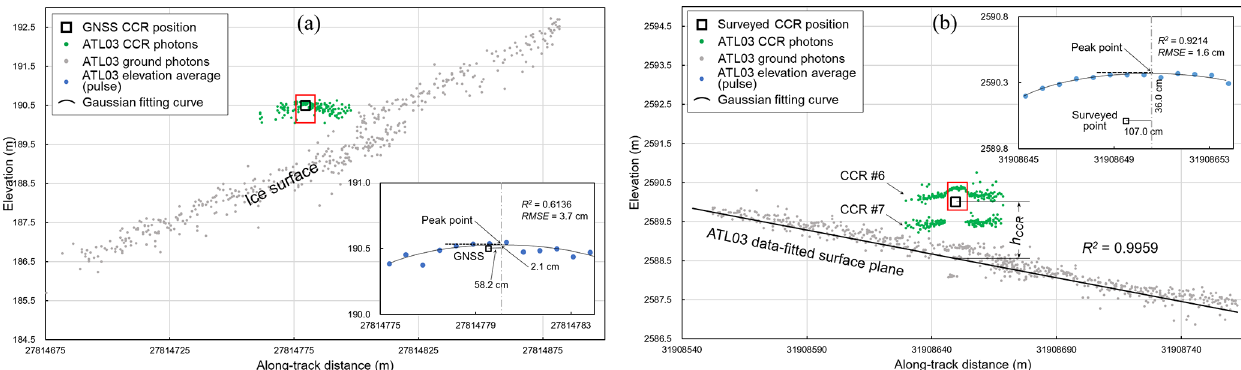
Figure 6. (a) CCR experiment near Zhongshan Station: returned CCR photons (ATL03, green dots), GNSS-surveyed CCR position (black square), and ice surface photons (ATL03, gray dots); inset: elevations averaged in each pulse (blue dots) in the enlarged red rectangle in (a) for fitting a Gaussian curve. (b) CCR experiment near Taishan Station: returned CCR photons (ATL03, green dots), steel-tape-surveyed CCR position (black square), and h CCR – height between CCR center and ice surface (ATL03, gray dots); inset: elevations averaged in each pulse (blue dots) in the enlarged red rectangle in (b) for fitting a Gaussian